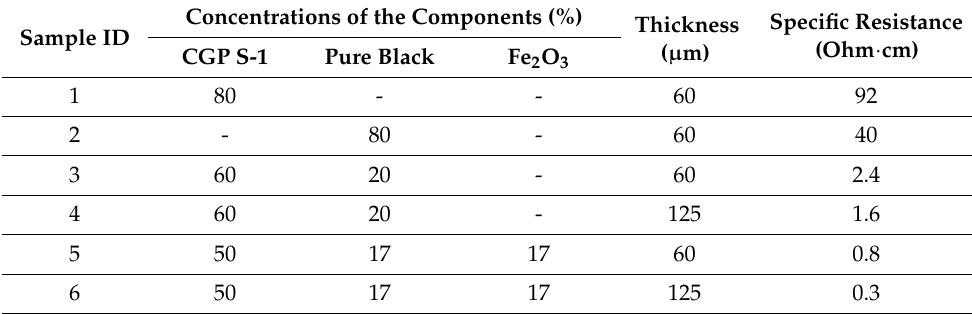
Table 2. Specific resistance of thin composite